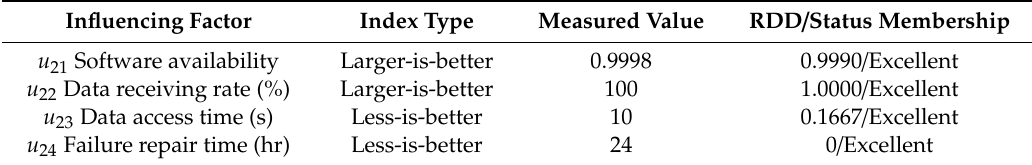
Table 5. SCADA human–machine interface (HMI) software status data and status evaluation.